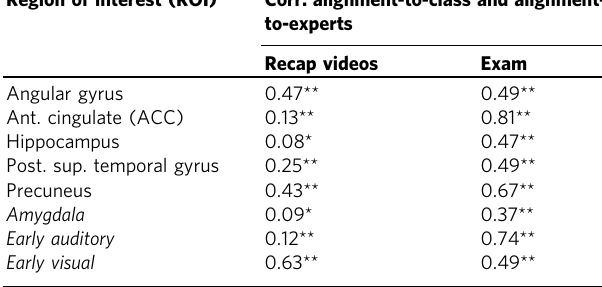
Table 3 Alignment-to-experts is positively correlated with alignment-to-class during recaps and during fi nal